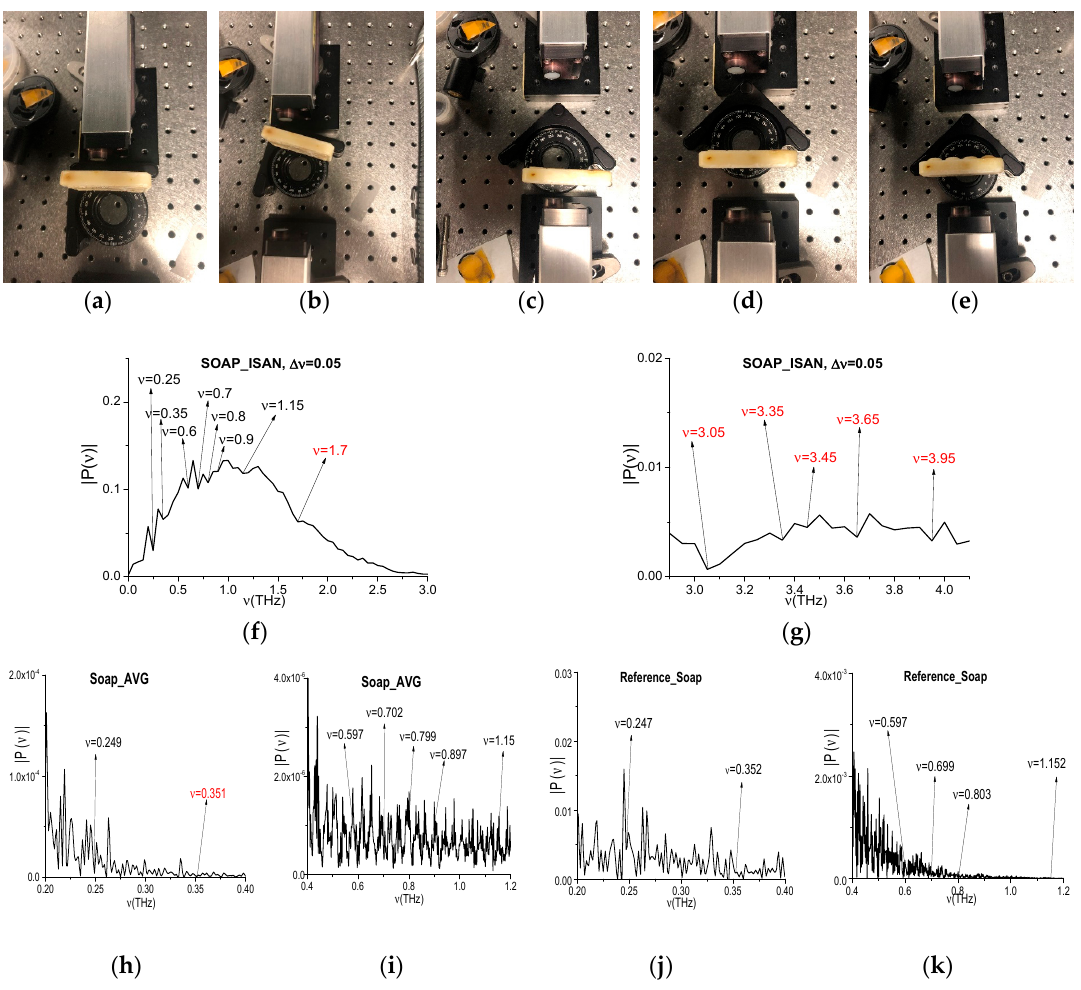
Figure 14. Soap in the THz spectrometer ( a – e ), Soap_BB spectrum in the frequency ranges ν = [0, 3.0] THz ( f ) and [3.0, 4.0] THz ( g ), Soap_AVG spectrum in the frequency ranges ν = [0.2, 0.4] THz ( h ) and [0.4, 1.2] THz ( j ). Reference spectrum ( j , k ).